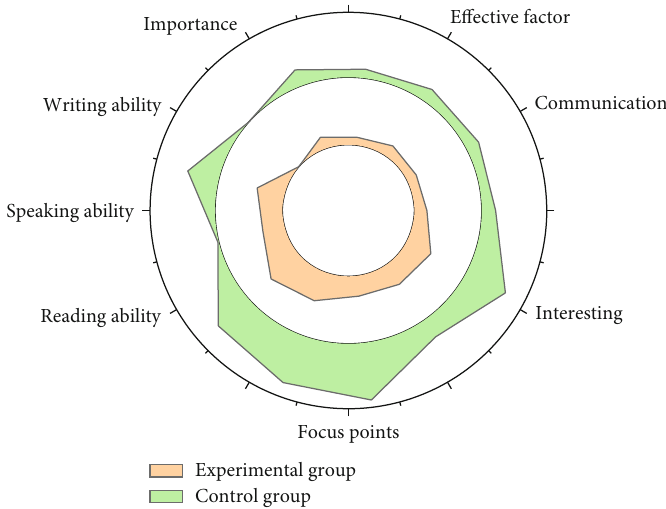
Figure 6: Statistical analysis of students ’ interest in reading before the